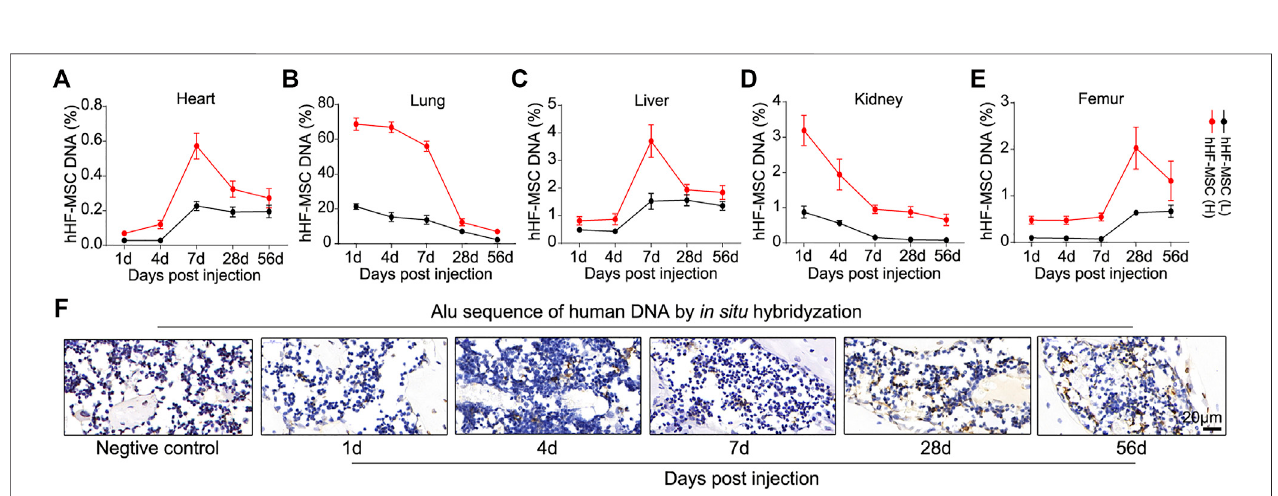
FIGURE6| Invivo distributionofintravenoustransplanted hHF-MSCsinOVX-inducedosteoporoticmice. (A – E) Thepercentage ofexogenoushHF-MSCsDNAin DNAofheart,lung,liver,kidney,andfemurofmiceatday1,4,7,28,and56afterthesecondhHF-MSCsinjectiondeterminedbyqPCRusingprimersforAlusequences. ( n = 6 for each group). (F) In situ hybridization analysis against Alu sequences in the bone marrow of femur at day 1, 4, 7, 28, and 56 after the second high-dose hHF- MSCs injection. Hybridyzation reaction without probes was used as negative control. All the data were obtained from three independent experiments. Data were shown as the means ±